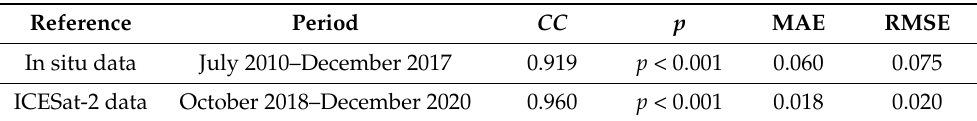
Table 3. Evaluation